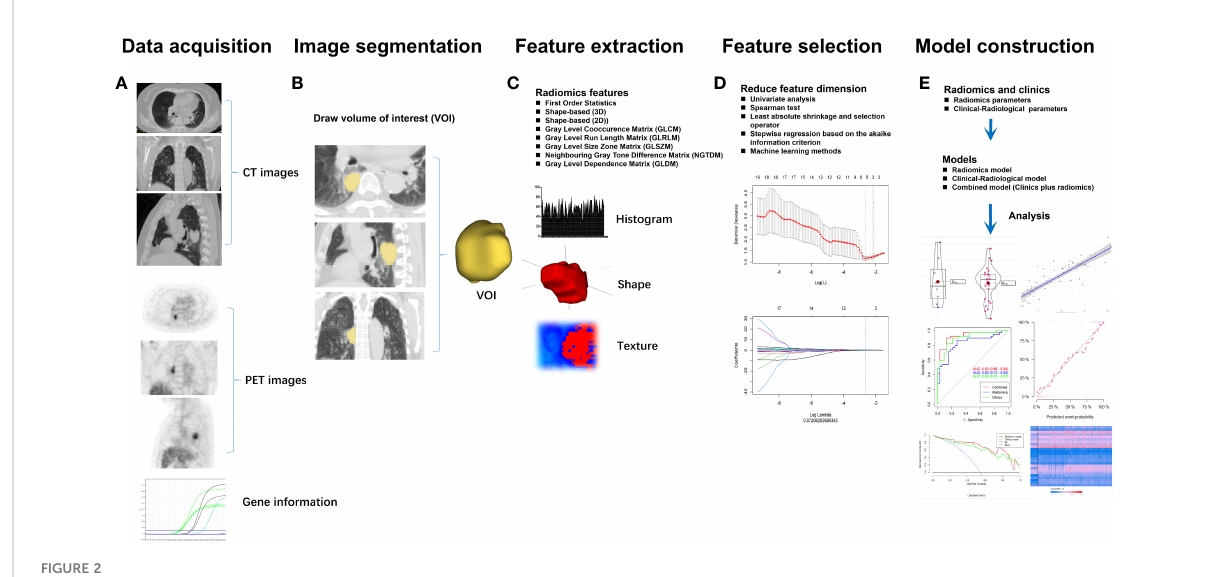
FIGURE 2 The work fl ow for radiomics analysis of 18 F-FDG PET/CT data comprises fi ve steps: (A) data acquisition, (B) image segmentation, (C) feature extraction, (D) feature selection, and (E) model